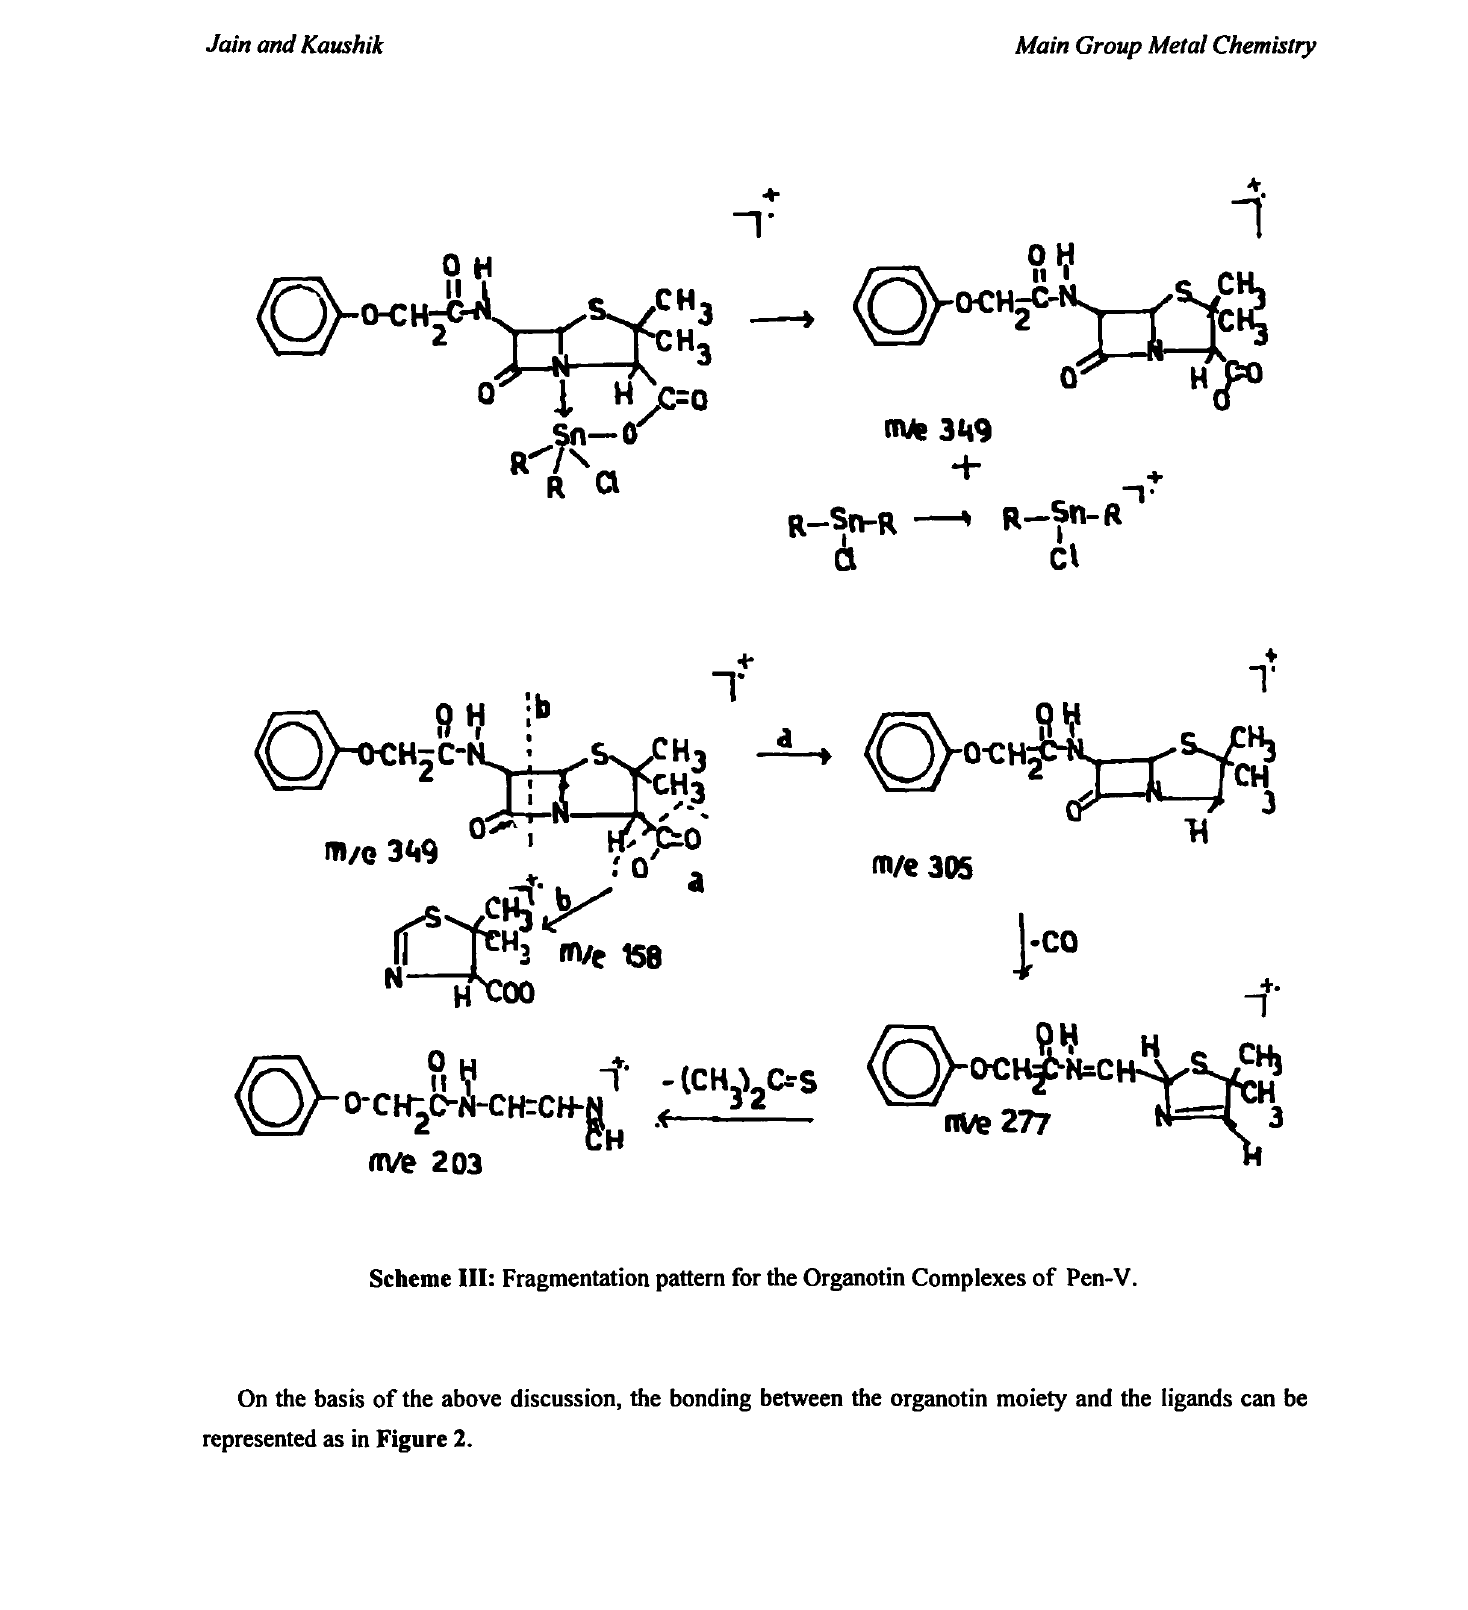
Scheme III: Fragmentation pattern for the Organotin Complexes of